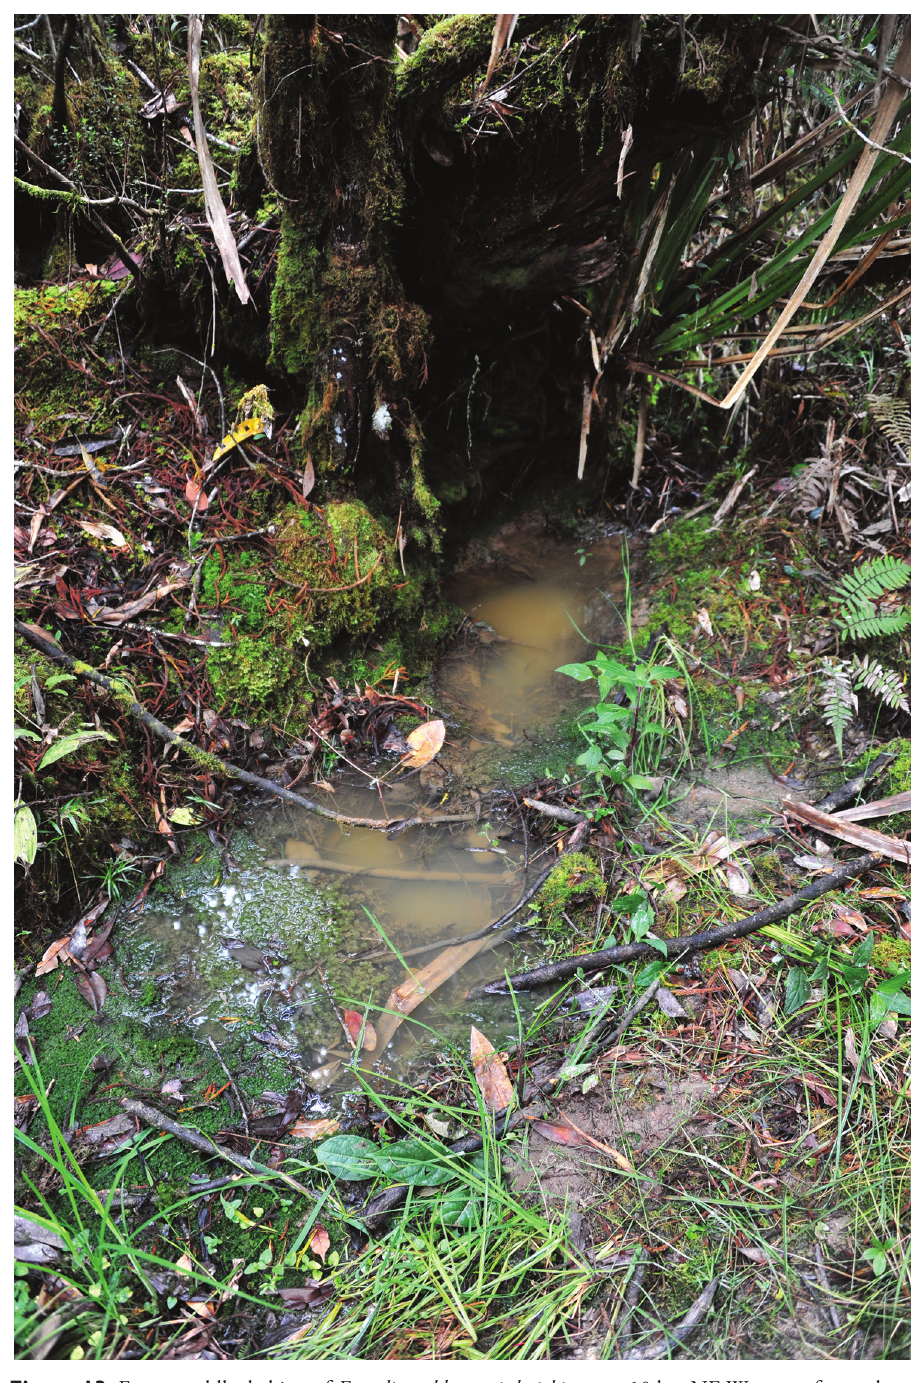
Figure 13. Forest puddle, habitat of Exocelina okbapensis hajeki ssp. n. 10 km NE Wamena, forest above ‘Baliem vall. Resort’. Photo by Jiří